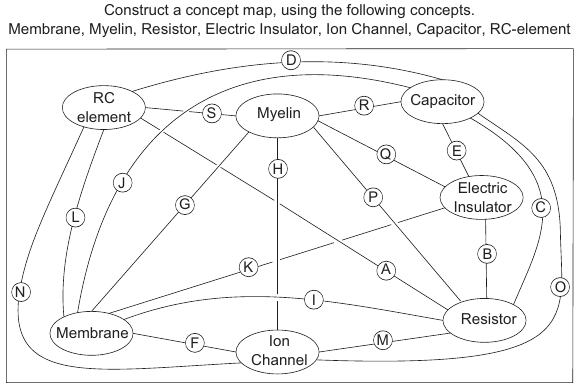
FIG. 4. An expert’s map, containing